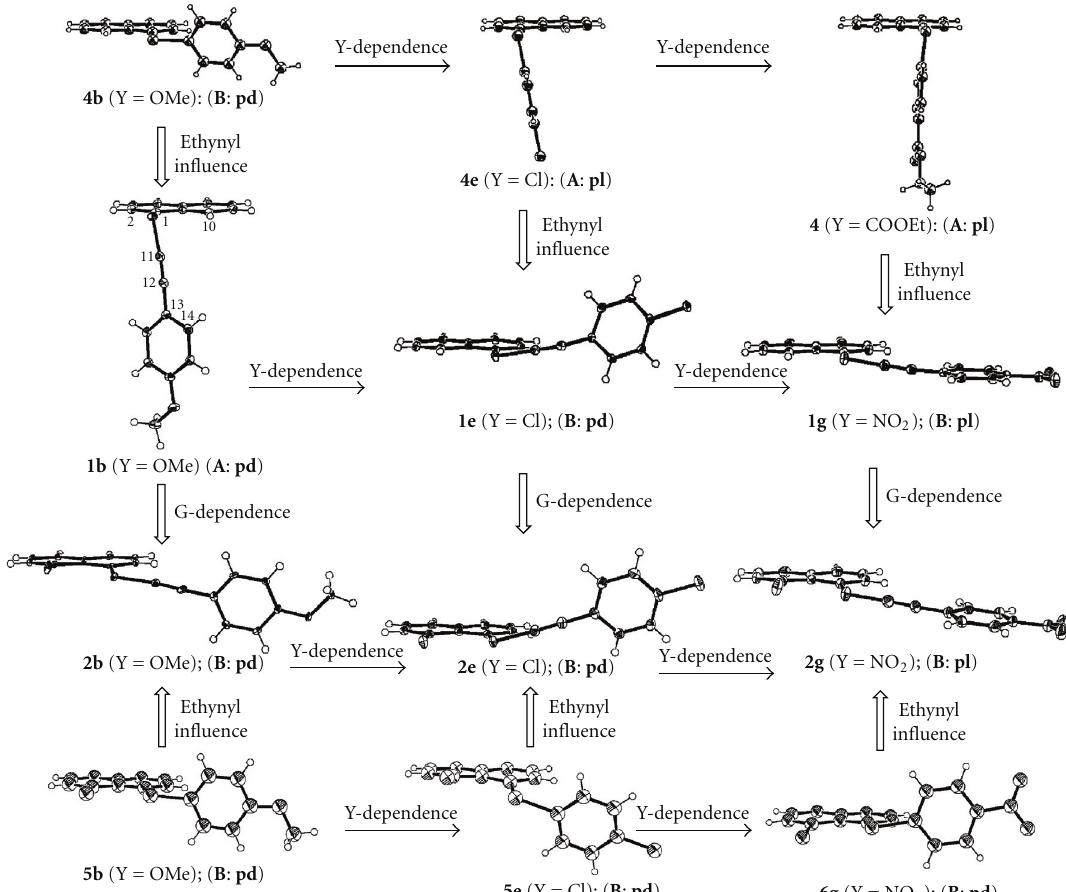
Figure 1: Ethynyl Influence in 1 and 2 and Y-dependence in 1 , 2 , and 4 – 6 .